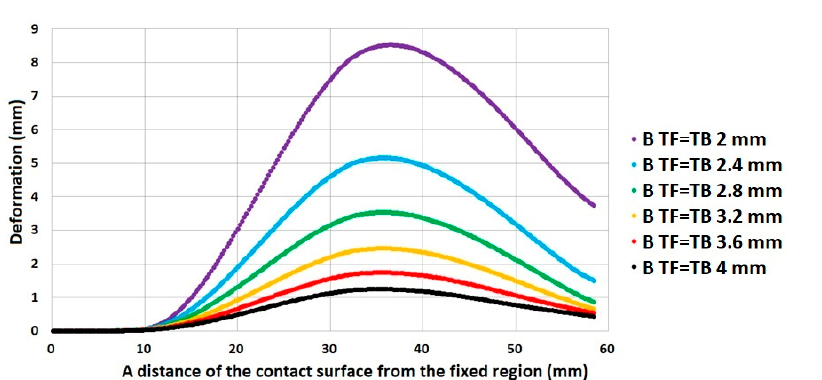
Figure 10. Fingers’ contact side deformation of the variants of structures B under load 5 N.